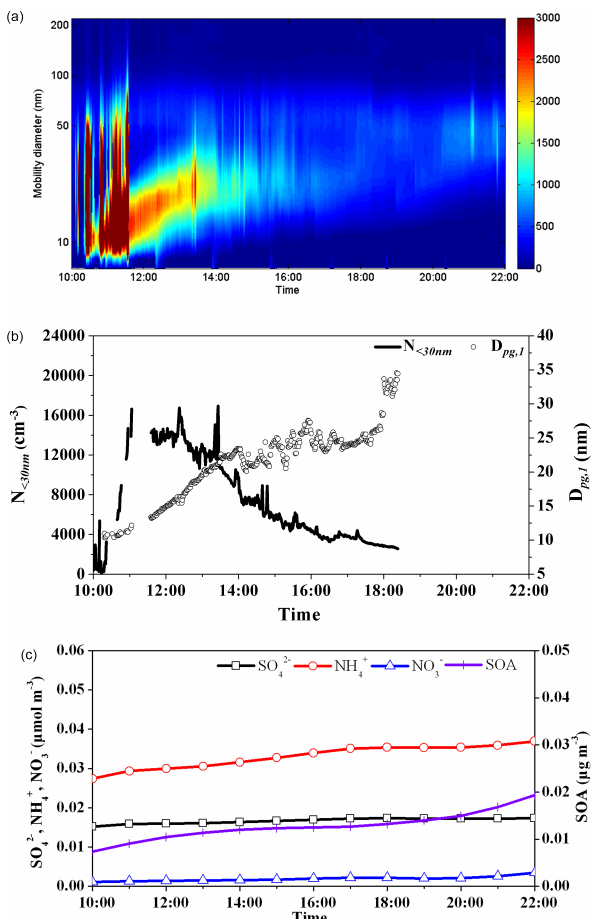
Figure 4. New particle formation on 18 October 2011, a particle number concentrations from FMPS (cm − 3 ), (b) variations of me- dian diameter of particle mode ( D pg , 1 ) and number concentrations , 4 of nucleation mode particles ( N < 30nm ), (c) CMAQ simulation of SO 2 − , NH + , NO − and SOA in PM 2 . 5 4 4 3